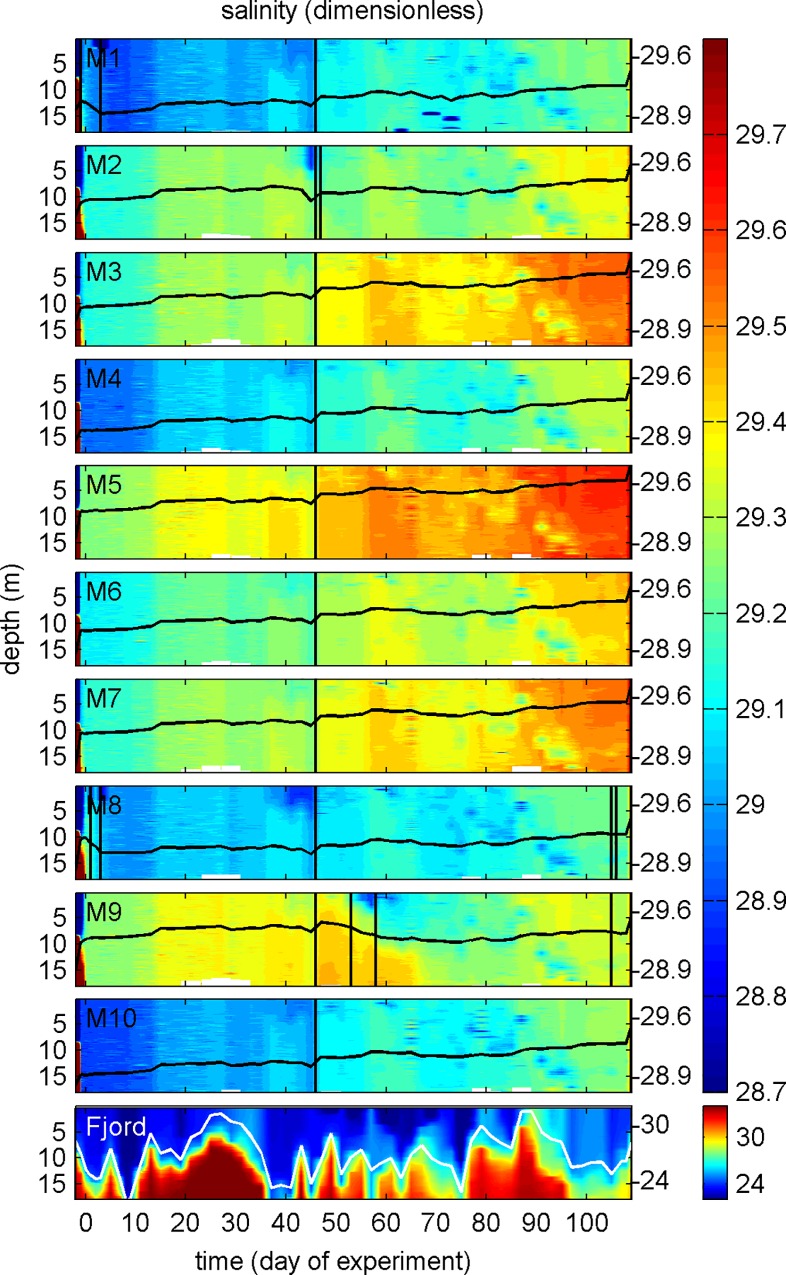
Salinity profiles over the course of the study.Note the different color coding for the fjord contour plot. Change of salinity averaged over the entire water column is represented by the black (or white in the case of the fjord) line plots on top of the contours with the corresponding additional y-axes on the right side. The vertical black lines on t46 mark the volume determination by brine (NaCl) addition. The other vertical black lines frame periods where we had small holes in the mesocosm bags (influx estimates given in Table 2).